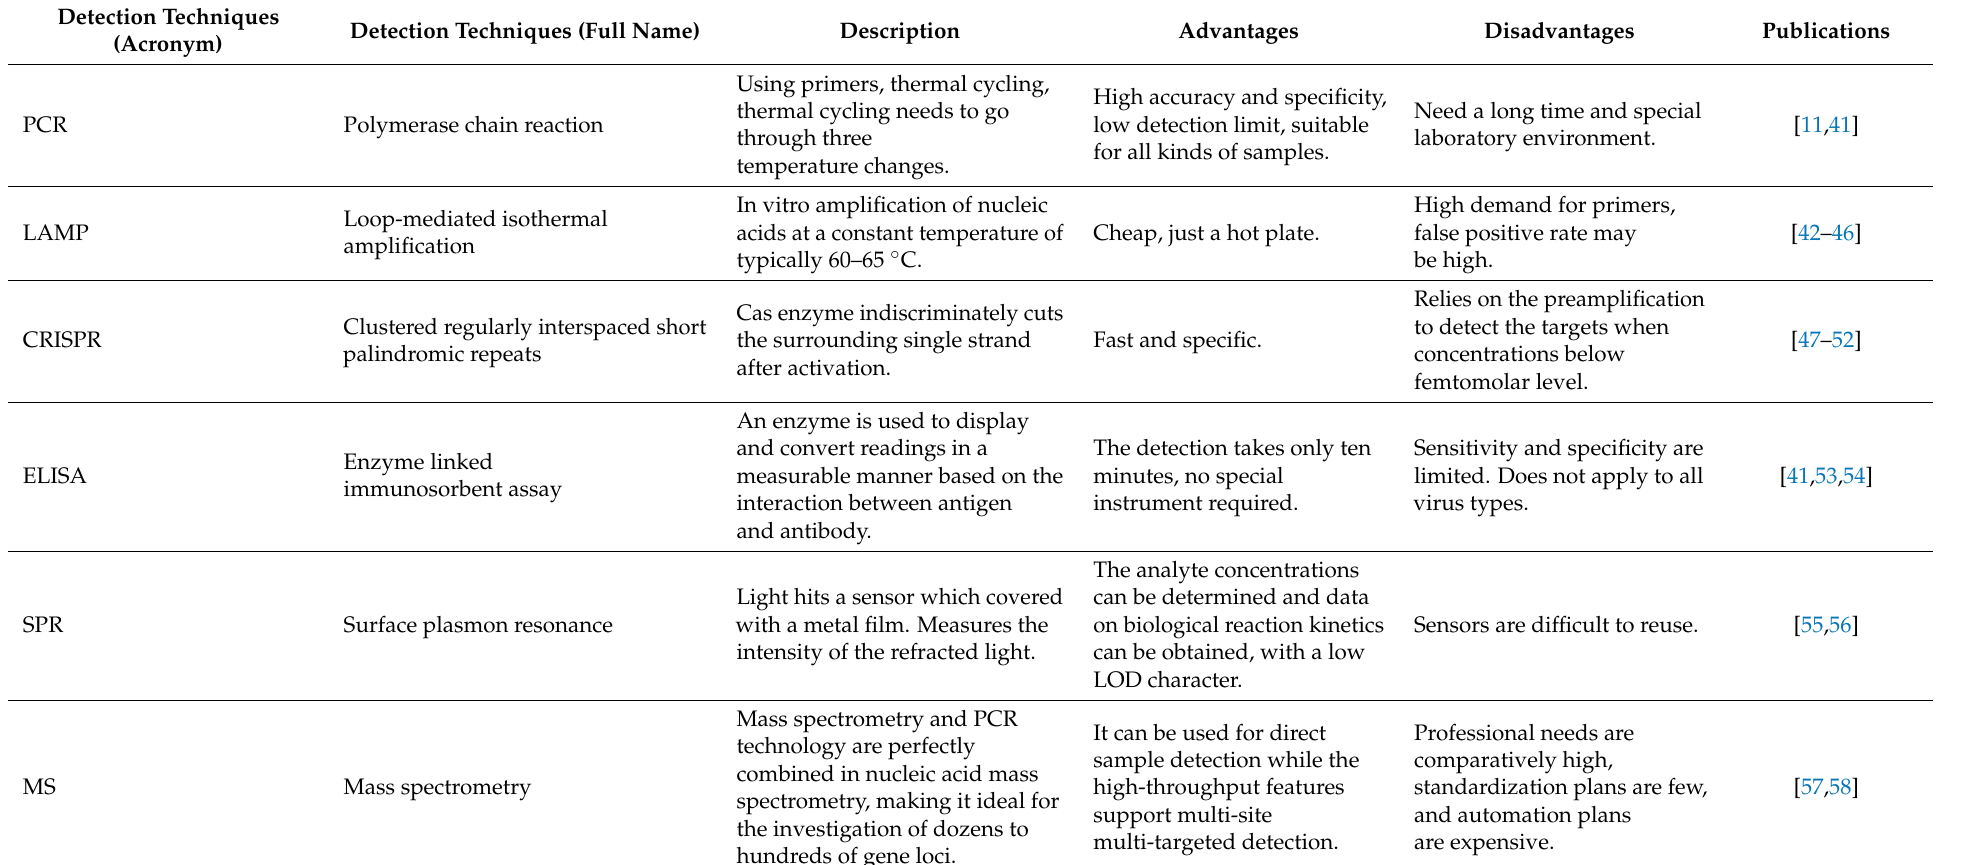
Table 2. Summary of potential detection techniques for airborne